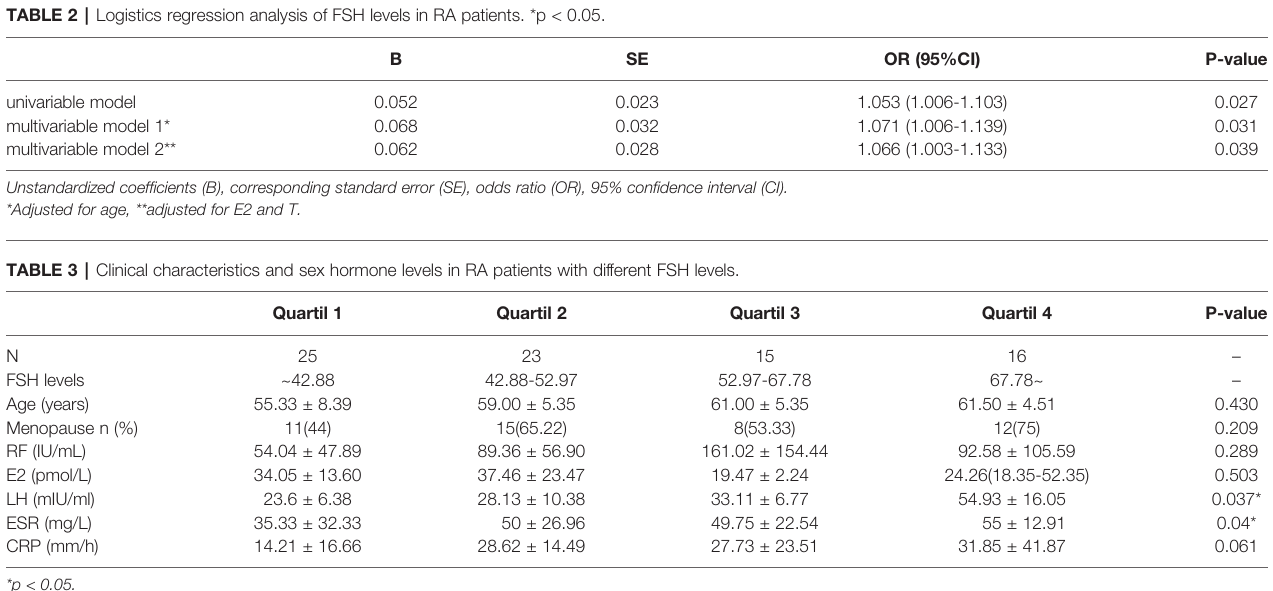
TABLE 2 | Logistics regression analysis of FSH levels in RA patients. *p < 0.05.